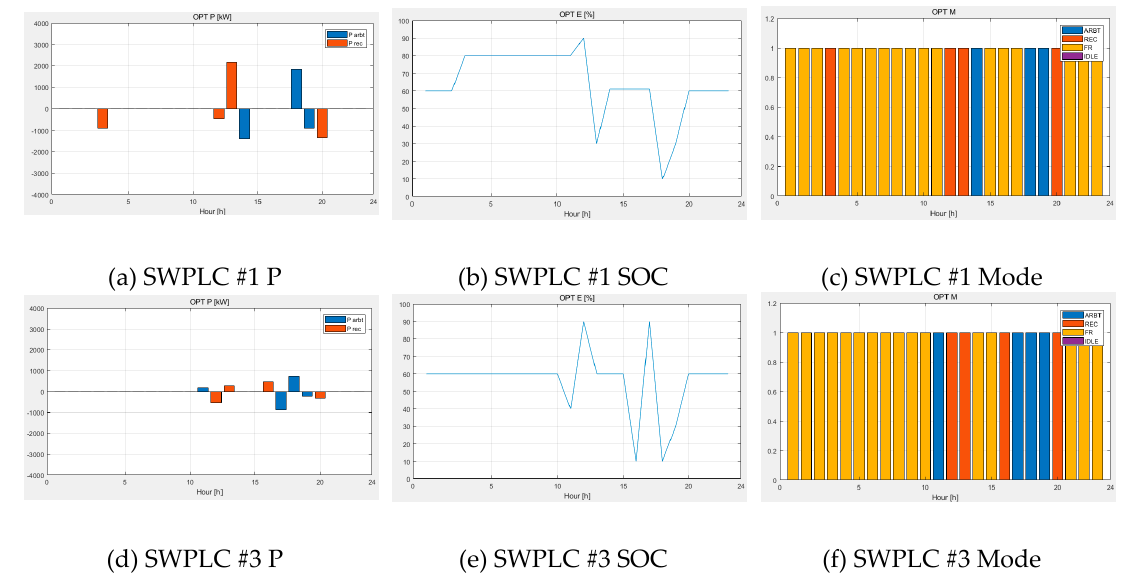
Figure 9. Scenario 4 simulation results.